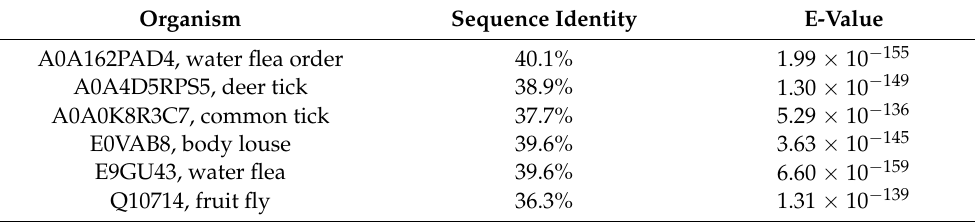
Table 1. BLAST sequence identities of ectoparasite ACEs and human ACE2.